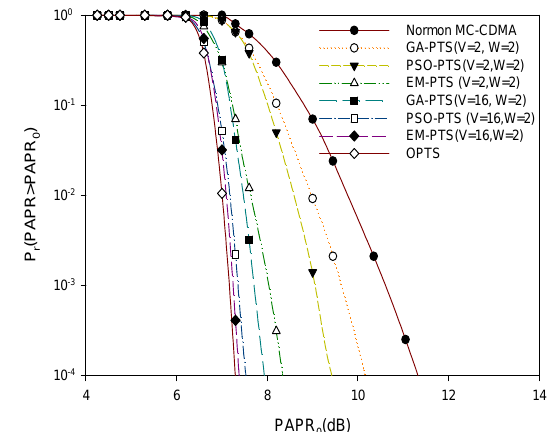
Fig. 3 CCDFs comparison of the EM, PSO, and GA based- PTS scheme with different combinations of sub- blocks when N =256, V =2 and 16, W =2.